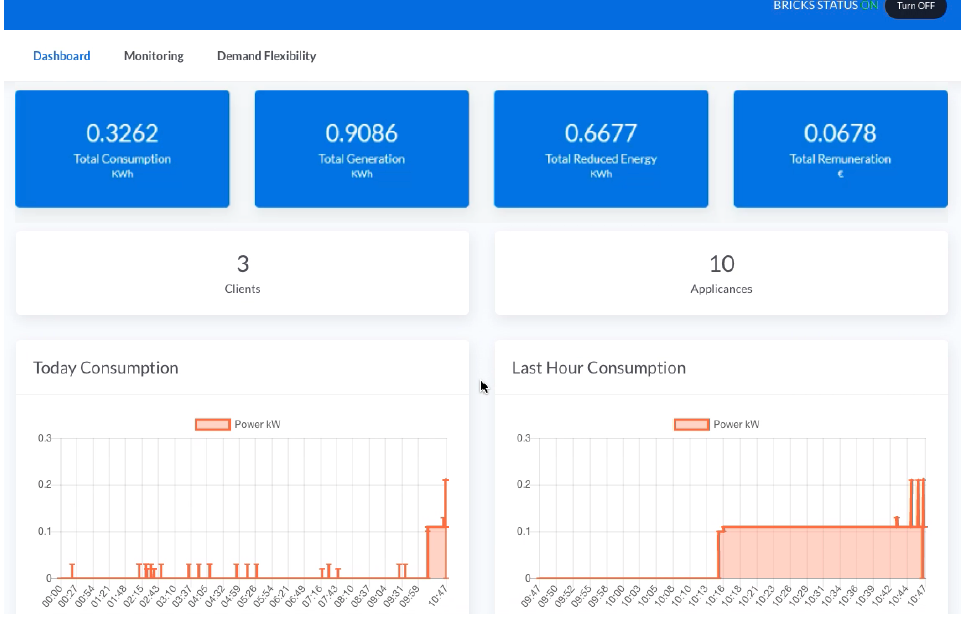
Figure 2. The business building